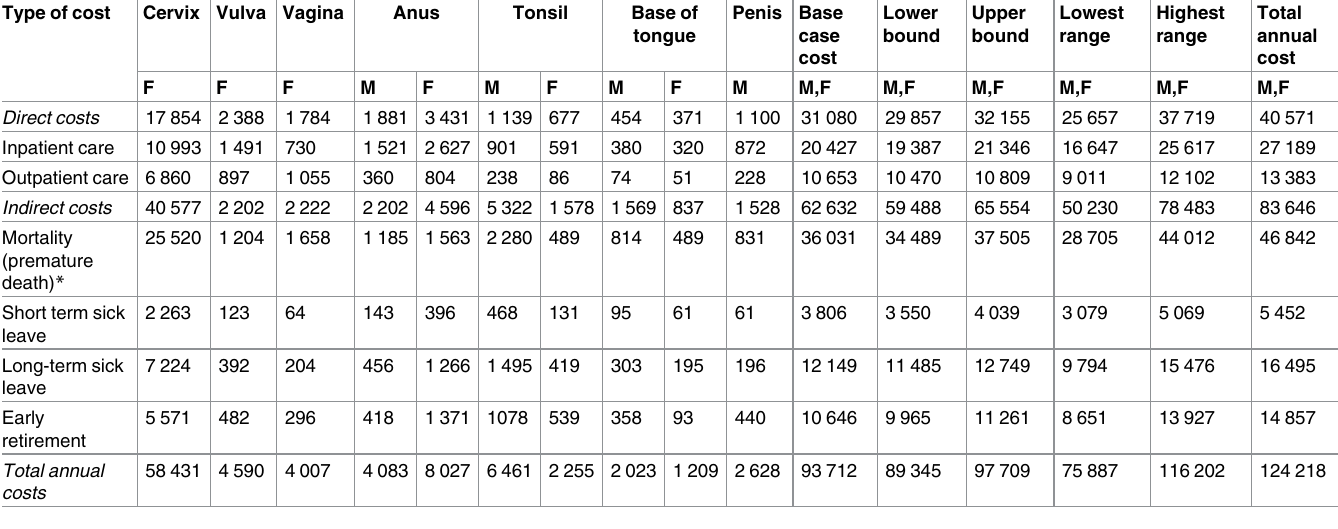
Table 5. Total annual HR HPV-attributable costs in Sweden in 2006, presented in € 1000. Type of